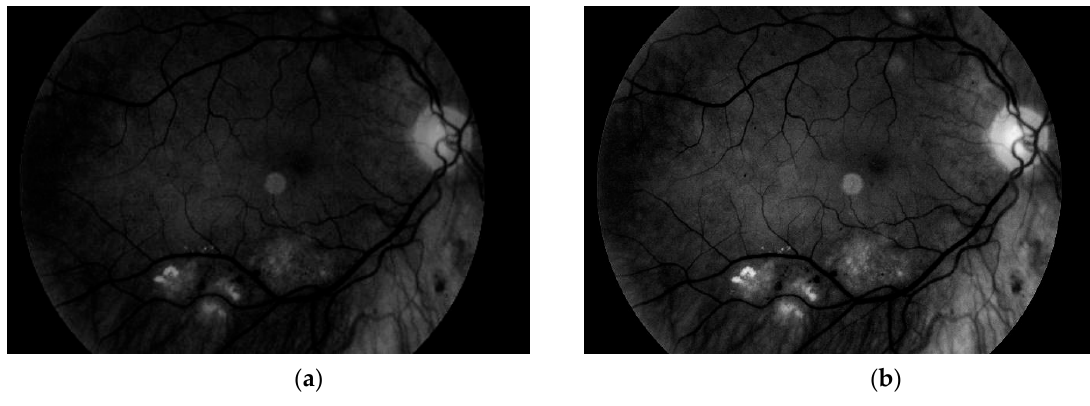
Figure 6. ( a ) Grayscale image and ( b ) its form after histogram stretching.